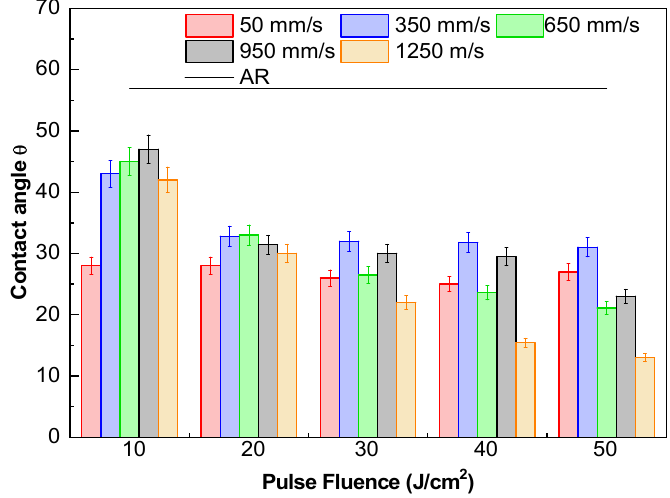
Figure 3. Contact angle of Titanium at varying pulse fluence and laser speed.